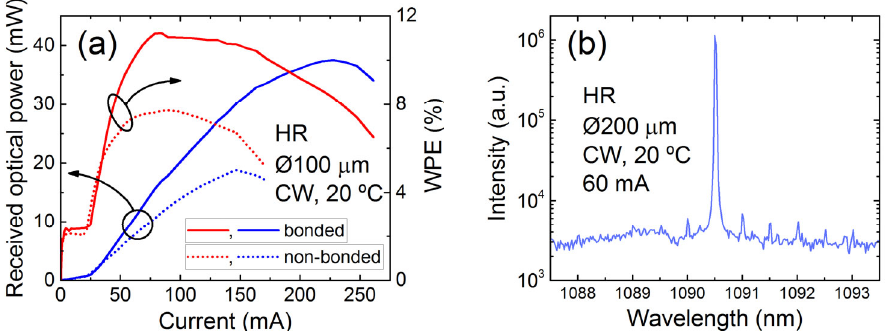
Figure 4. ( a ) The light–current curves and wall-plug efficiencies (WPEs) versus the injection current of p-side-up mounted (non-bonded) and bonded onto Si-board Ø100 µ m HRs. ( b ) The lasing spectra of a Ø200 µ m HR at 60 mA (the threshold current—42.7 mA).